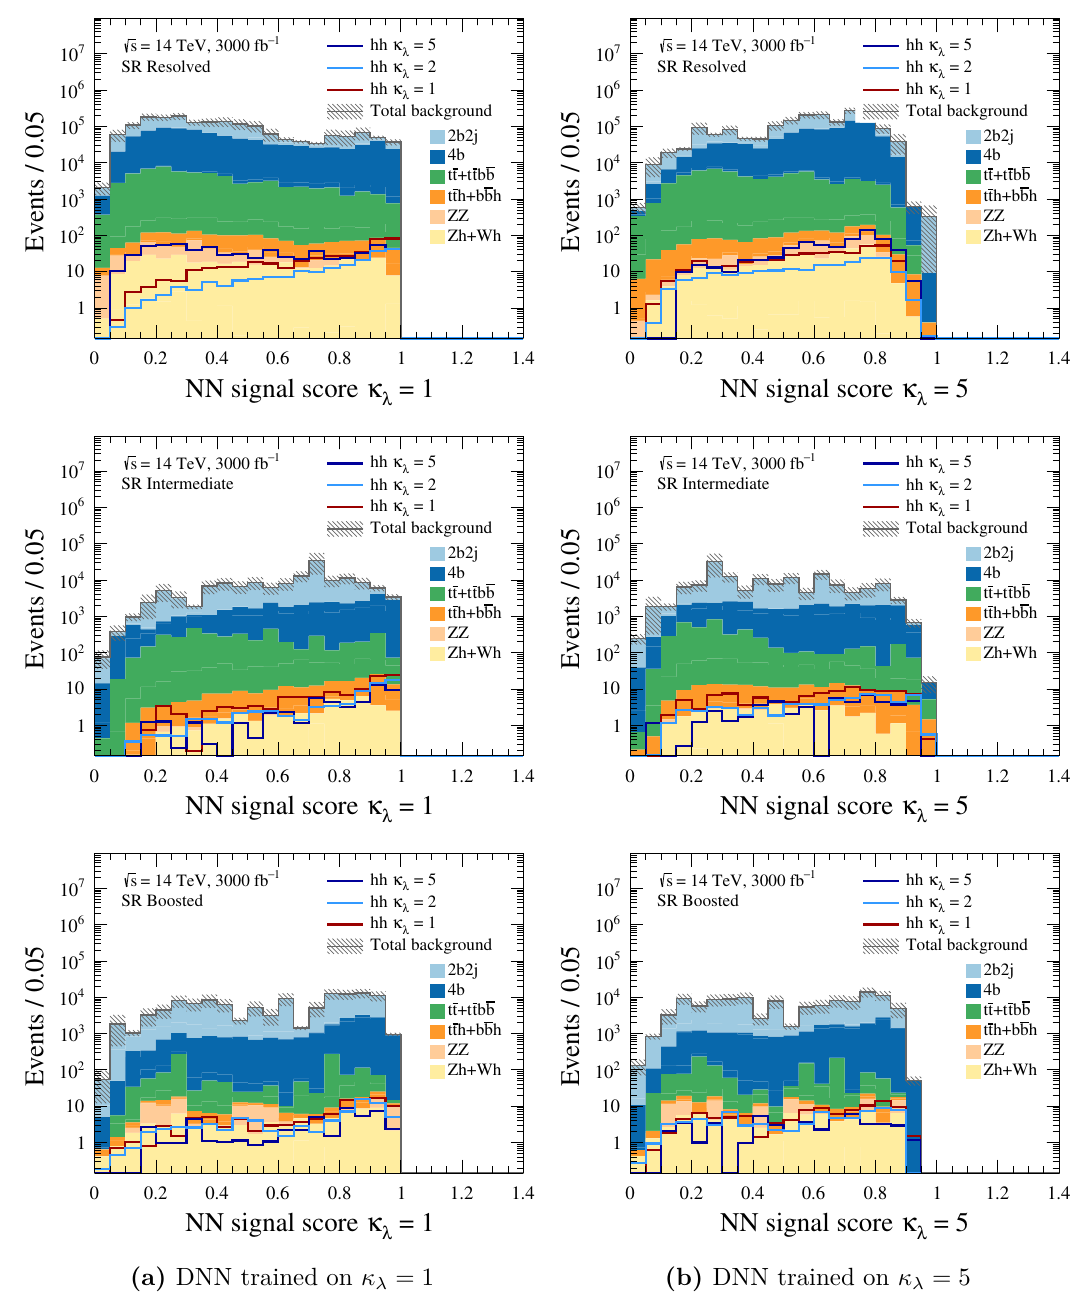
Figure 8. Neural network score distributions p DNN of benchmark signals (solid lines) and back- signal ground processes (filled stacked) displayed in the legend. All event selection criteria of the neural network analysis except the p DNN > 0 . 75 requirement are imposed. The DNN is trained on (a) signal κ λ = 1 and (b) κ λ = 5 signals. These are displayed for (upper) resolved, (middle) intermediate and (lower) boosted categories. The plots are normalised to L = 3000 fb − 1